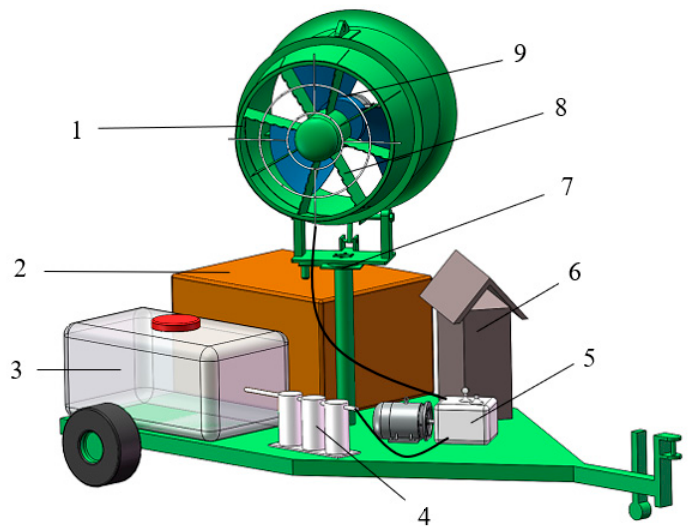
Figure 3. Spray cooling system. 1—Air duct; 2—Gasoline generator set; 3—Water tank; 4—3-stage